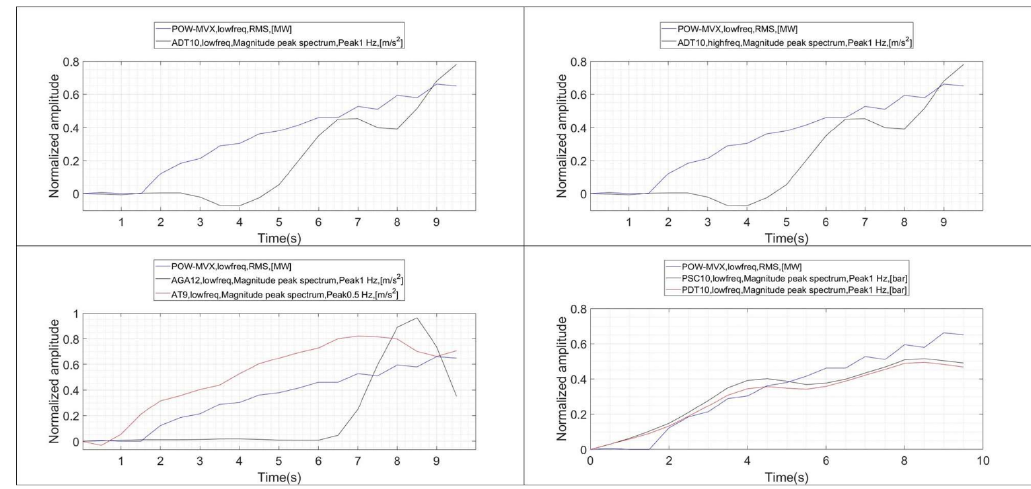
Figure 13. Evolution of the band f rope on the FFT and RMS of the power signal ( x FFT − rope vs. x RMS − power ).